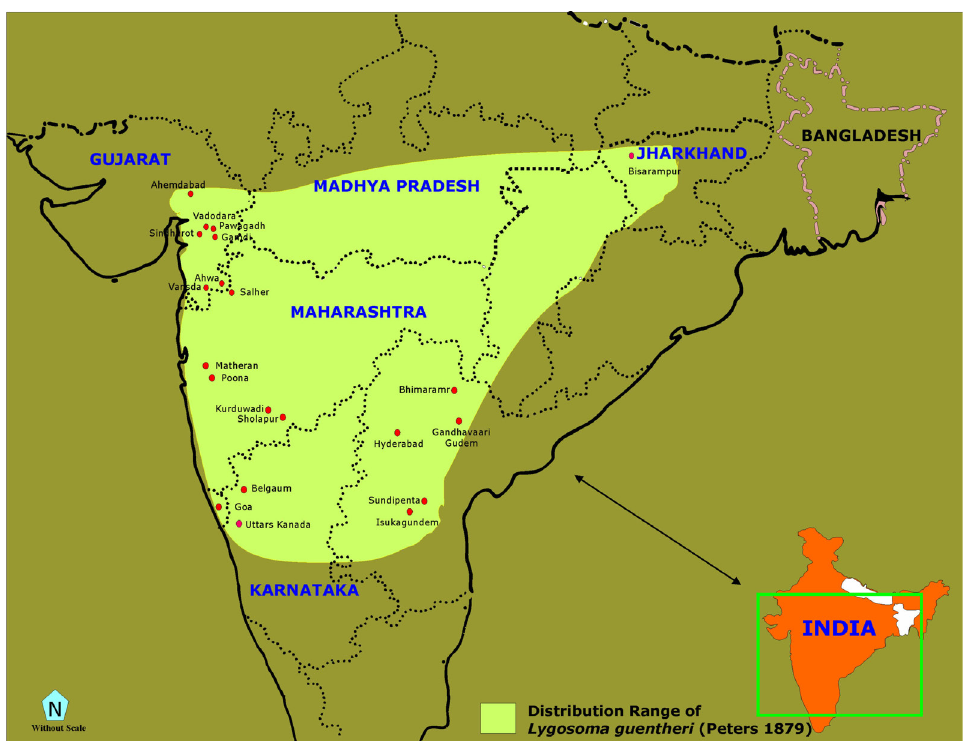
Figure 3. Distribution range and recorded collection sites of Lygosoma guentheri .